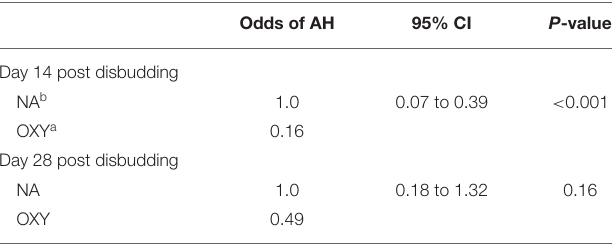
TABLE 3 | Mixed-effect logistic regression analyses for lesion healing with farm and calf accounted as random effects. Odds of